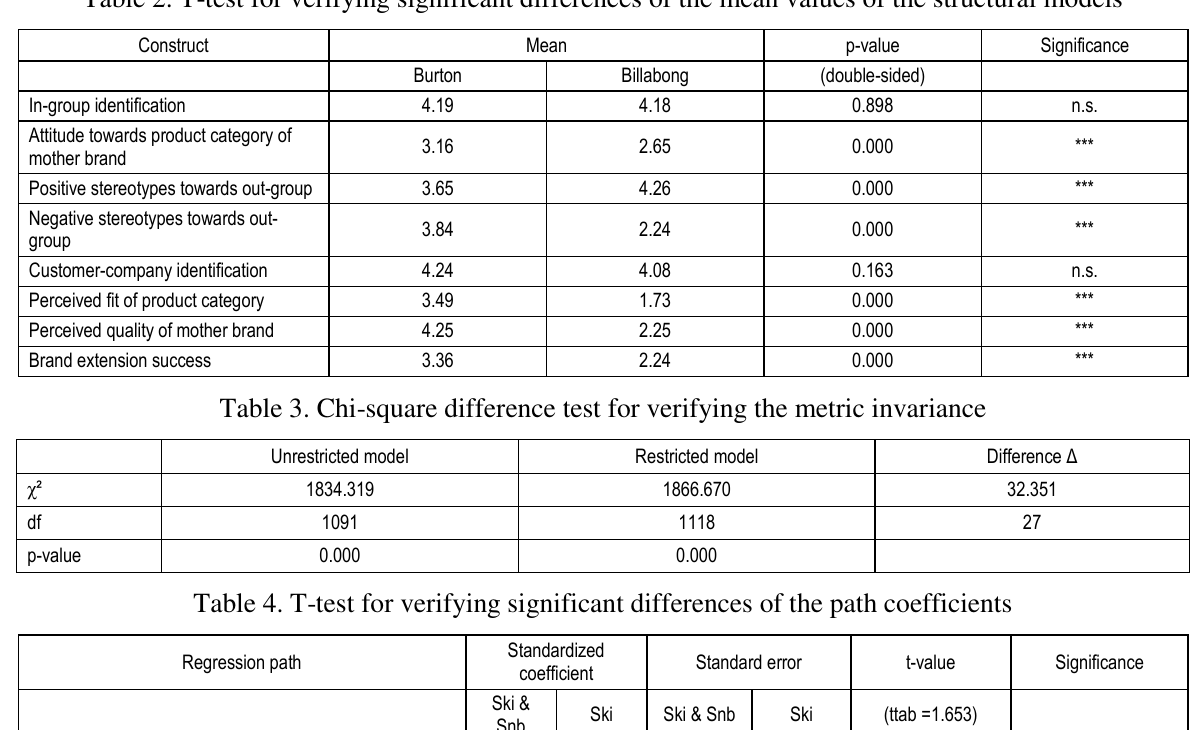
Table 2. T-test for verifying significant differences of the mean values of the structural models